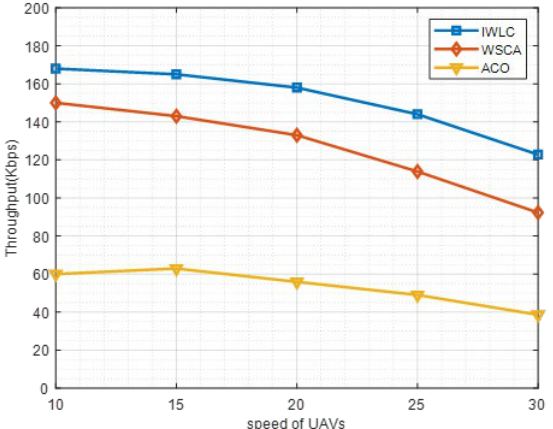
Figure 14. Throughput in different schemes with varying speeds of UAV nodes.